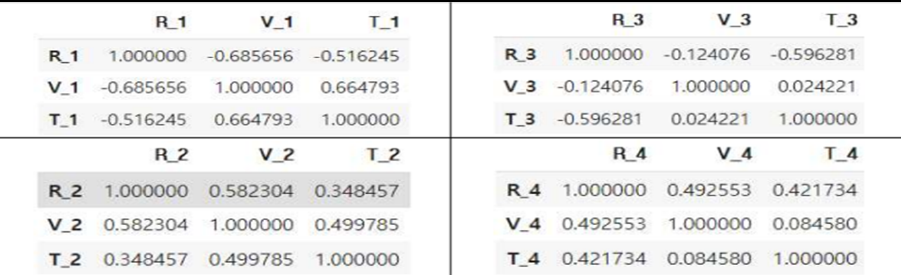
Figure 3. Correlation for each cell .